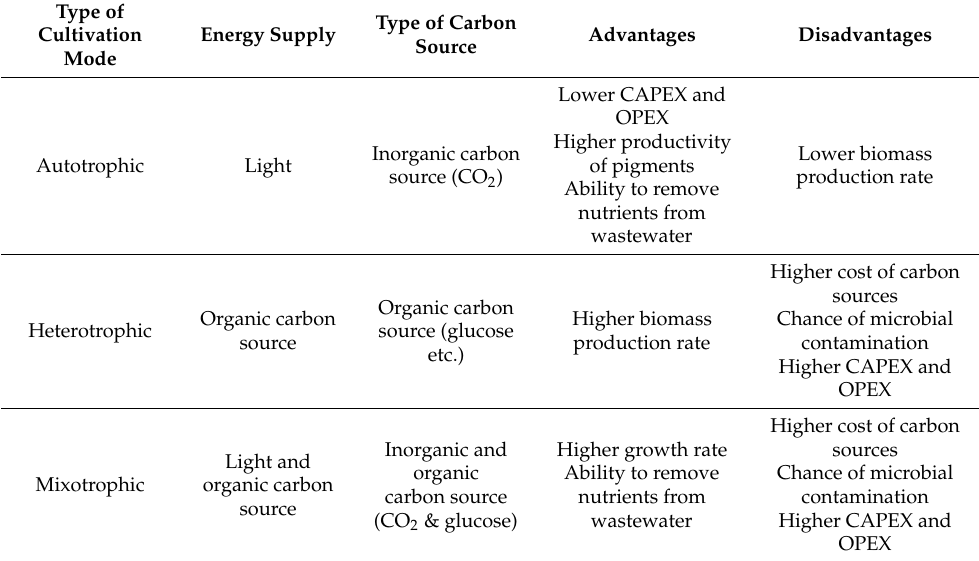
Table 3. The key variation in different microalgae cultivation mode as well as the main advantage and